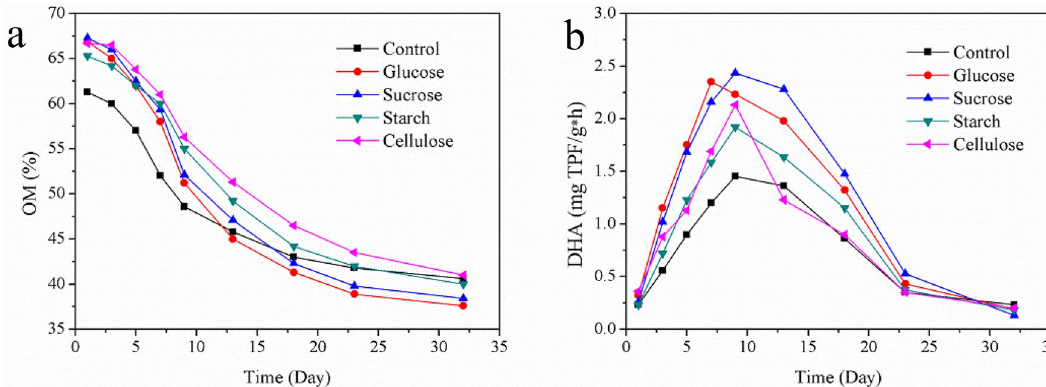
Figure 1. Evolutions of OM ( a ) and DHA ( b ) in five treatments.